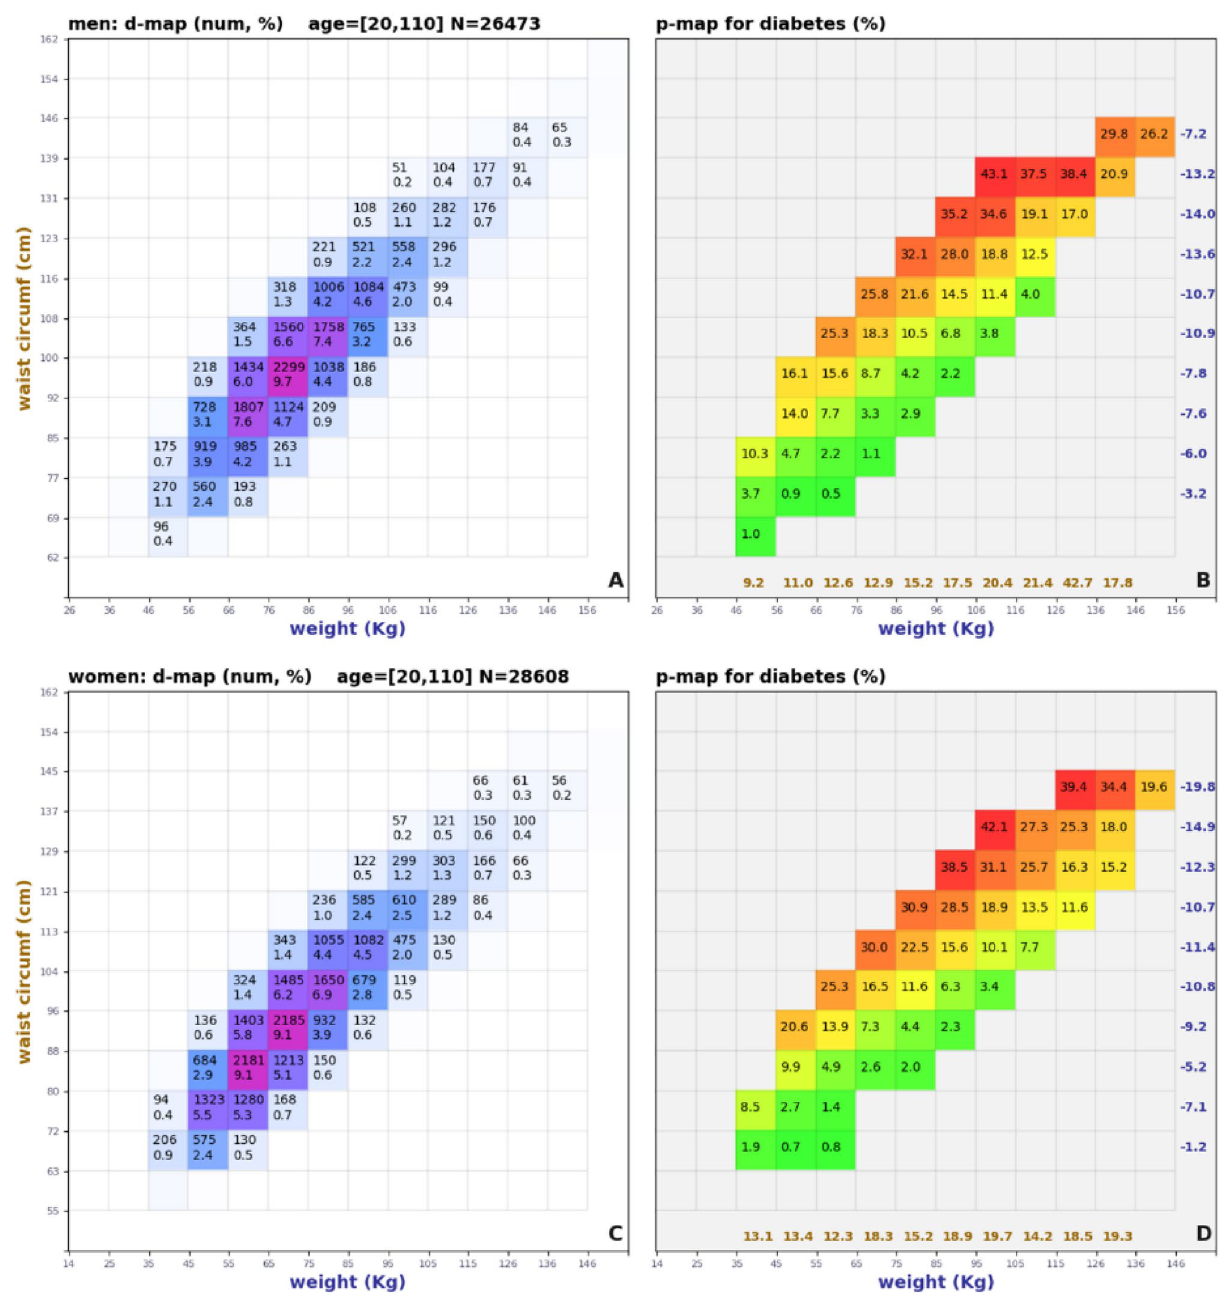
Figure 3. 2D biometric models for X = weight, Y = waist circumference, C = diabetes for adult men ( A , B ) and women ( C , D